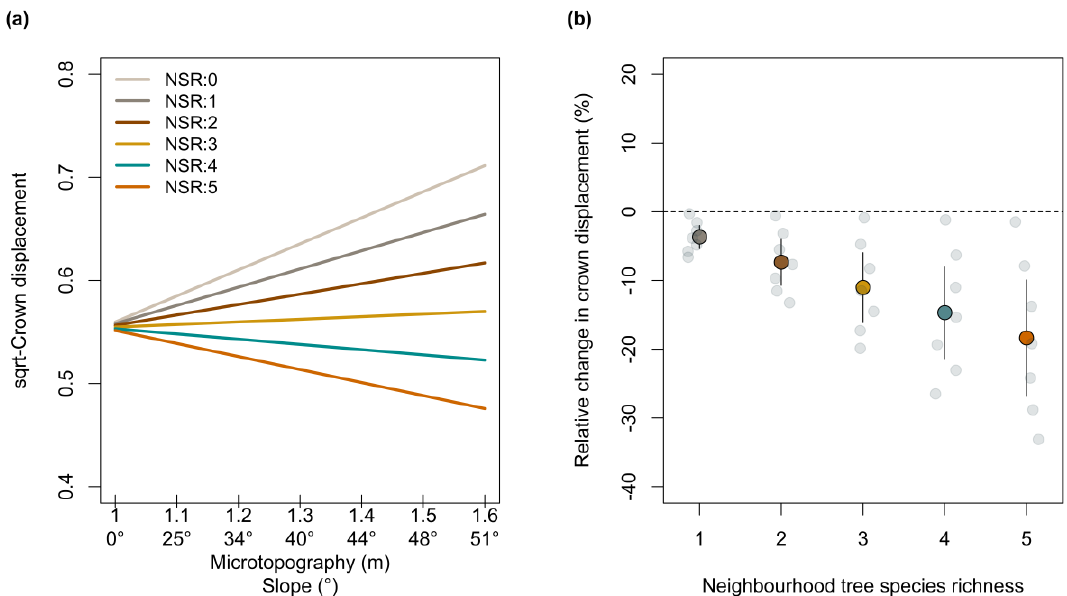
Figure 5. ( a ) Effects of microtopography (MT) on crown displacement (square root-transformed) with varying levels of neighbourhood tree species richness (NSR). Lines represent mixed-effects model fits (with target tree height and neighbourhood pressure kept at its mean). X-axis shows MT in meters and its conversion to slope in degrees. ( b ) Relative changes (%) in crown displacement between conspecific neighbourhoods (NSR: 0) and heterospecific neighbourhoods (NSR: 1–5). Dots represent predicted means based on a mixed-effects model (with target tree height kept at its mean), and error bars indicate the 95% confidence interval of the prediction. Grey points (slightly jittered to facilitate visibility) represent predictions for each level of the microtopography gradient ranging from 1 to 1.6 (see panel ( a )).